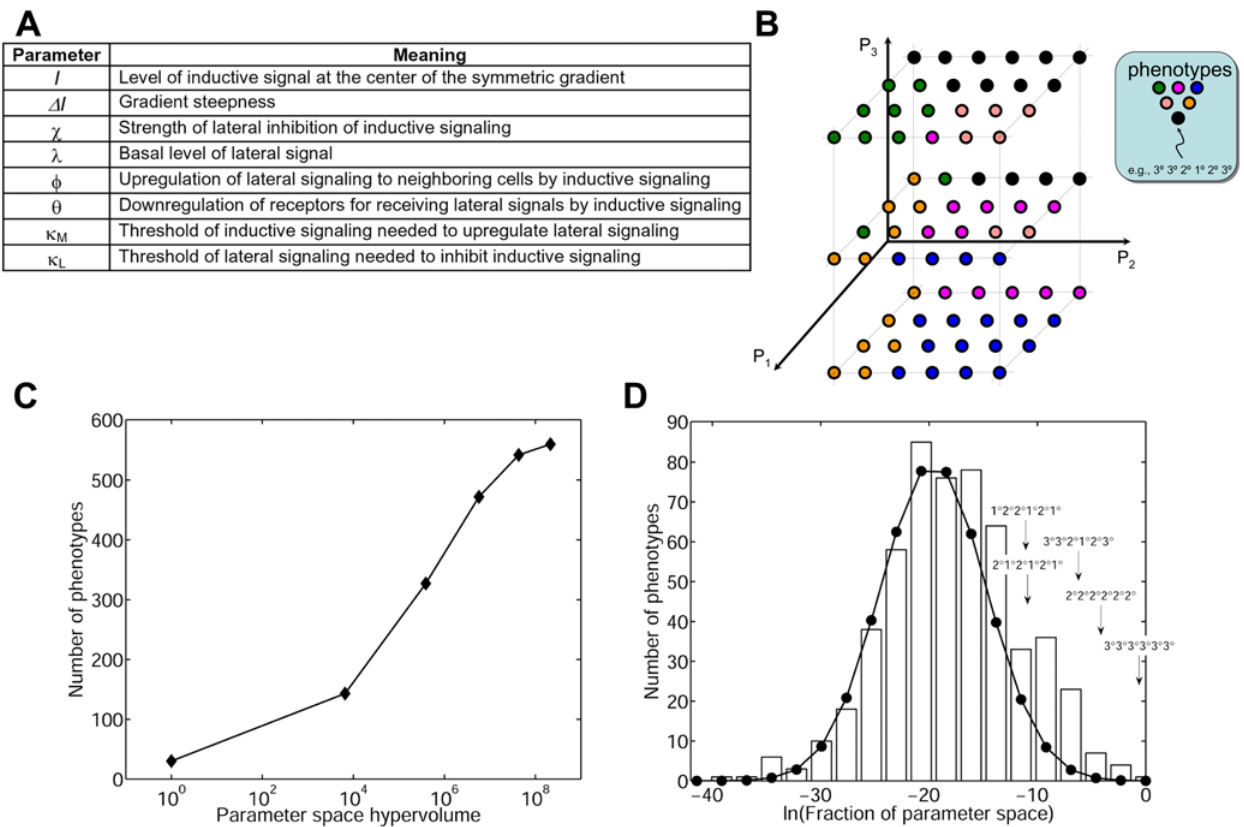
Figure 2. The predicted phenotypic diversity accessible to the vulval developmental network. (A) Model parameters. The model has eight dimensionless parameters associated with the various molecular interactions known to contribute to the specification of vulval precursor cells (see also Materials and Methods). (B) Schematic of the phenotype phase diagram. This diagram portrays a simplified, three-dimensional version of the 8-dimensional phenotype phase diagram. Each axis represents a model parameter. Each point in parameter space yields a specific multicellular phenotype, such as the wild-type (3 u 3 u 2 u 1 u 2 u 3 u , black). (C) The total number of predicted phenotypes eventually saturates as the volume of the parameter space is expanded. (D) Distribution of parameter space occupancy (PSO). A histogram depicting the number of phenotypes (bars) occupying different fractions of the parameter space. This histogram is compared to a log-normal distribution (filled circles). The arrows indicate the PSO values of some experimentally observed